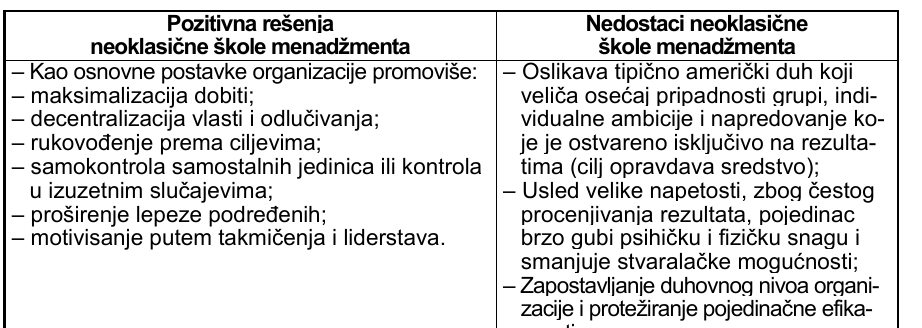
Neoklasi č na škola menadžmenta – doprinosi i nedostaci Neoclassical management school – merits and shortcomings Pozitivna rešenja neoklasi č ne škole menadžmenta